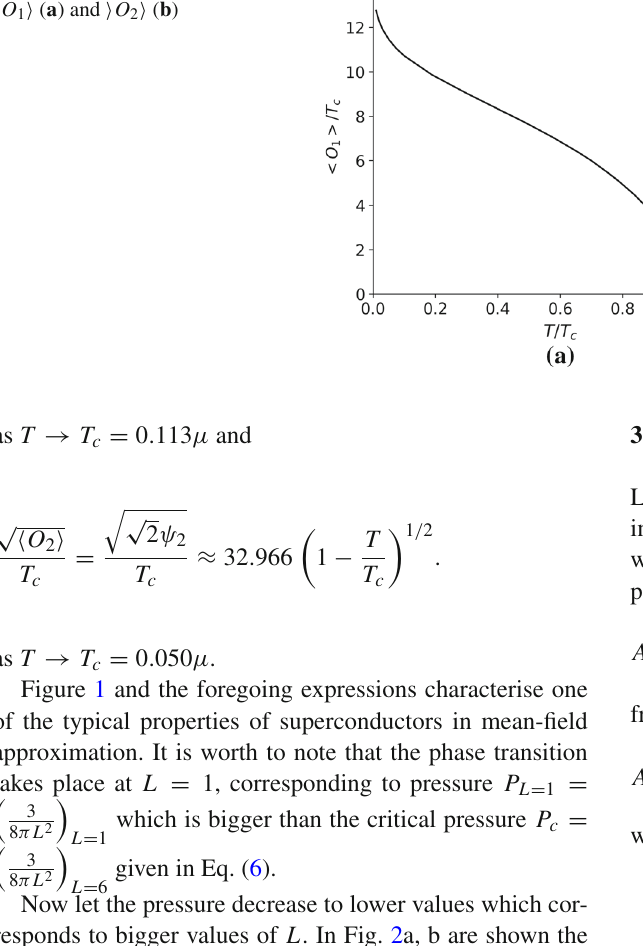
Fig. 1 The condensation of (cid:9) O (cid:9) ( a ) and (cid:9) O 1